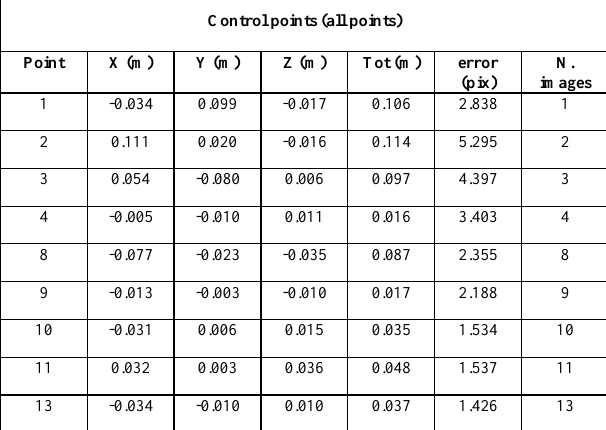
Table 2. Results using all targets as control points.